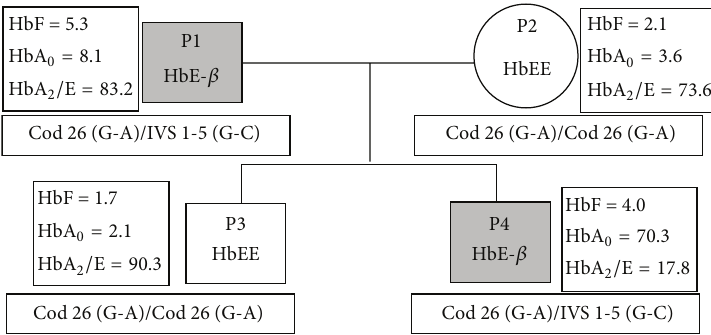
Figure 1: Pedigree of the family along with major clinical and mutational